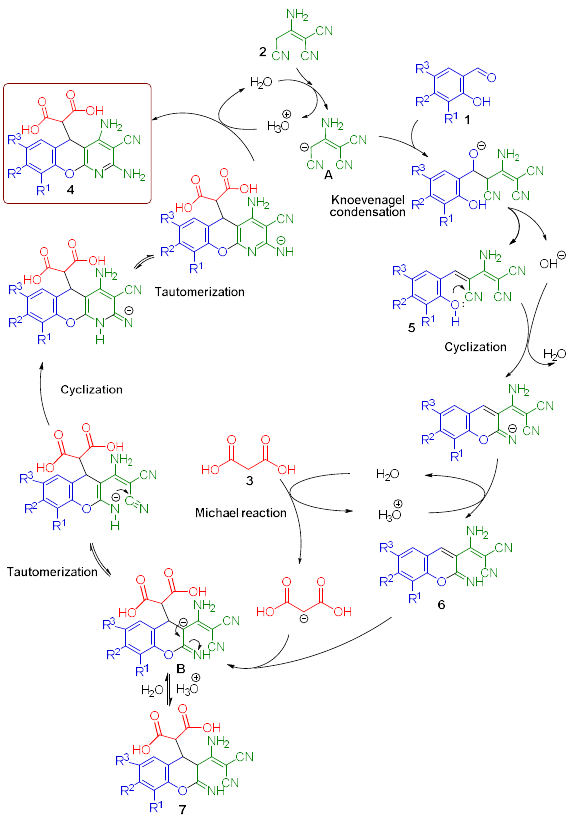
Figure 2. Representative 1 H-NMR spectrum of multicomponent reaction in DMSO- d 6 at 313 K rec- orded 45 min after